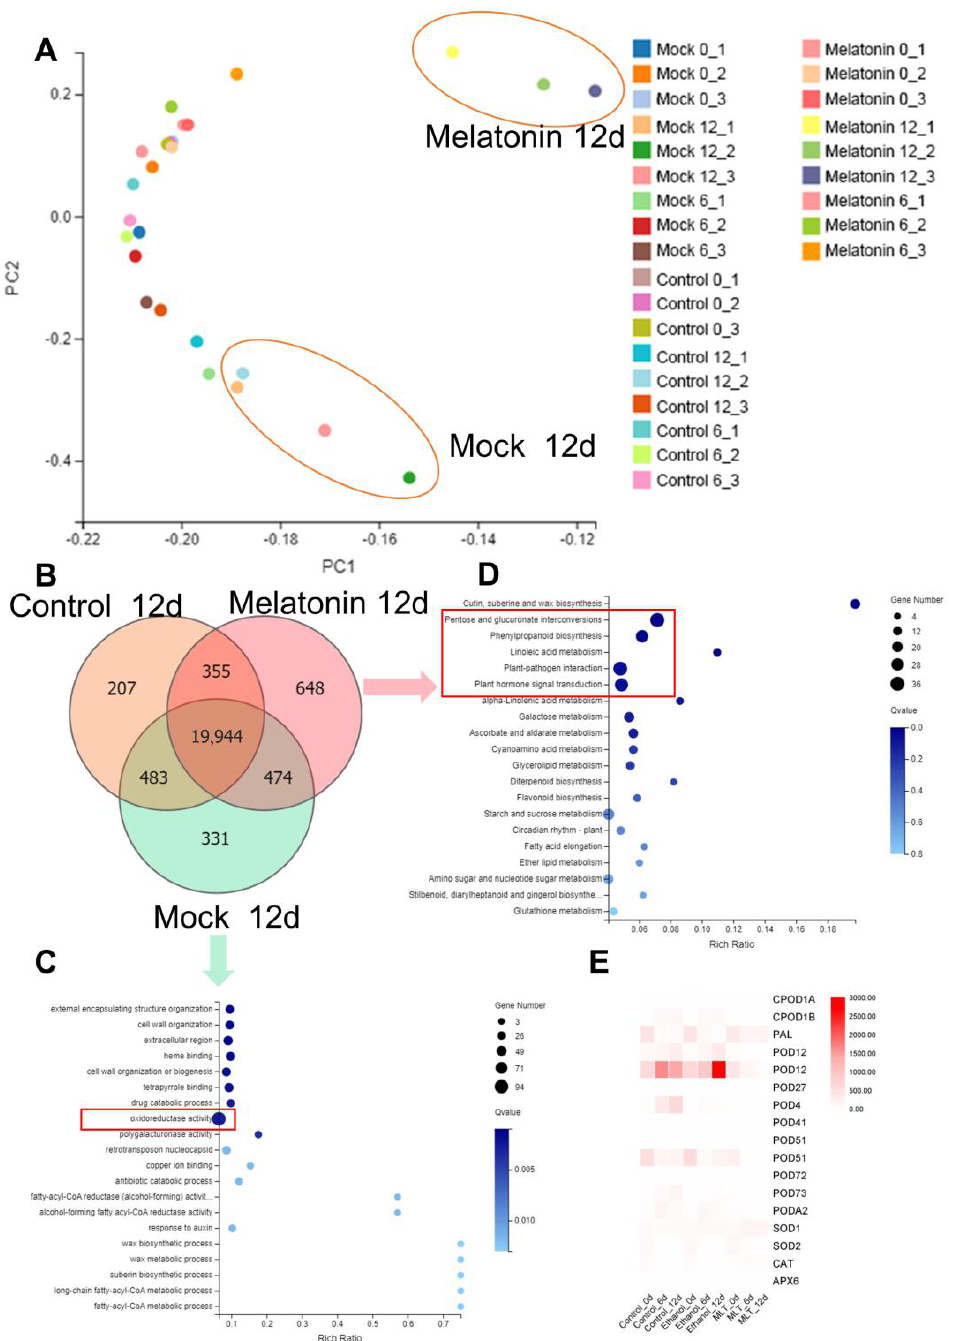
Figure 5. The expression profiles of fresh-cut lotus roots treated with melatonin solution. ( A ) PCA, principal component analysis. ( B ) Venn diagrams of groups in fresh-cut lotus root (Mock), fresh-cut lotus root treated with ethanol solution (CK), and fresh-cut lotus root treated with melatonin dissolved in ethanol solution (Melatonin); samples were all collected after 12 days. ( C , D ) KEEG pathway enrichment of specific expression genes in different groups. ( E ) Heat map of the expression profiles of ROS-related genes in the transcriptome.